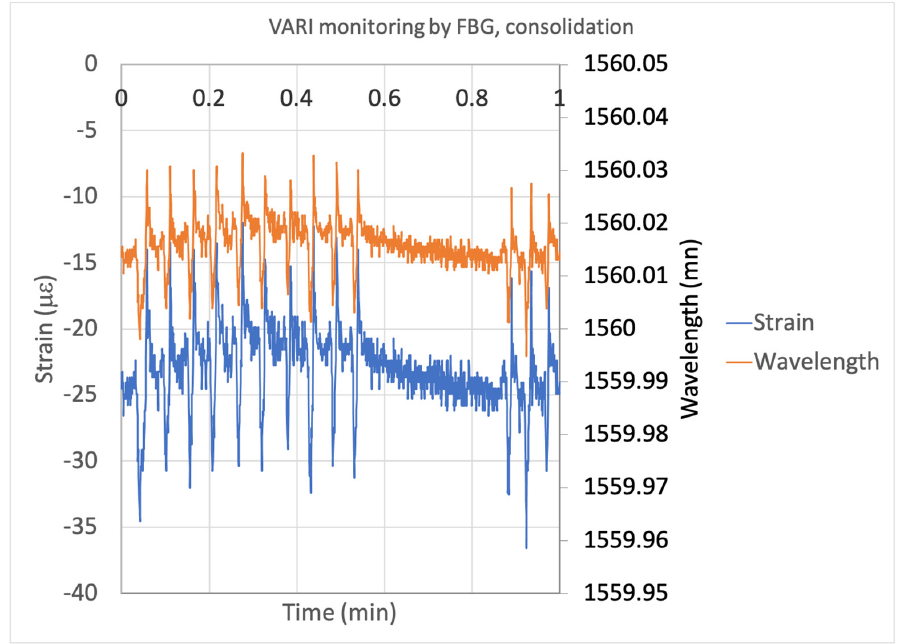
optical fiber sensor, giving measurements below − 70 με , as illustrated on Figure 12.